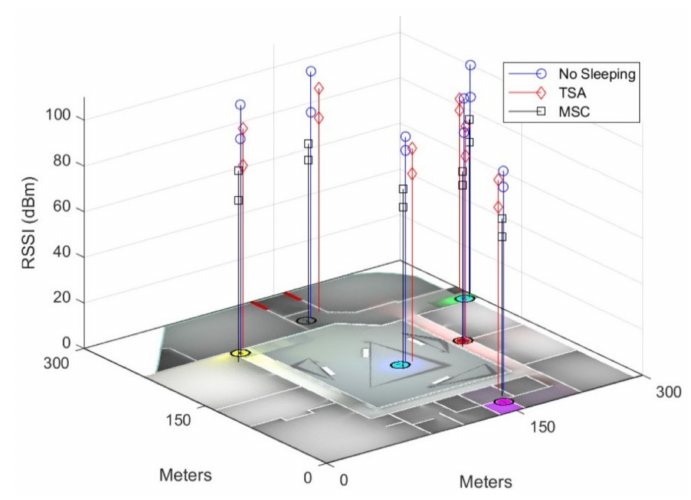
Figure 8. Analysis of the WiFi sensors under no sleeping, TSA, and MSC for AODV (reactive protocol).